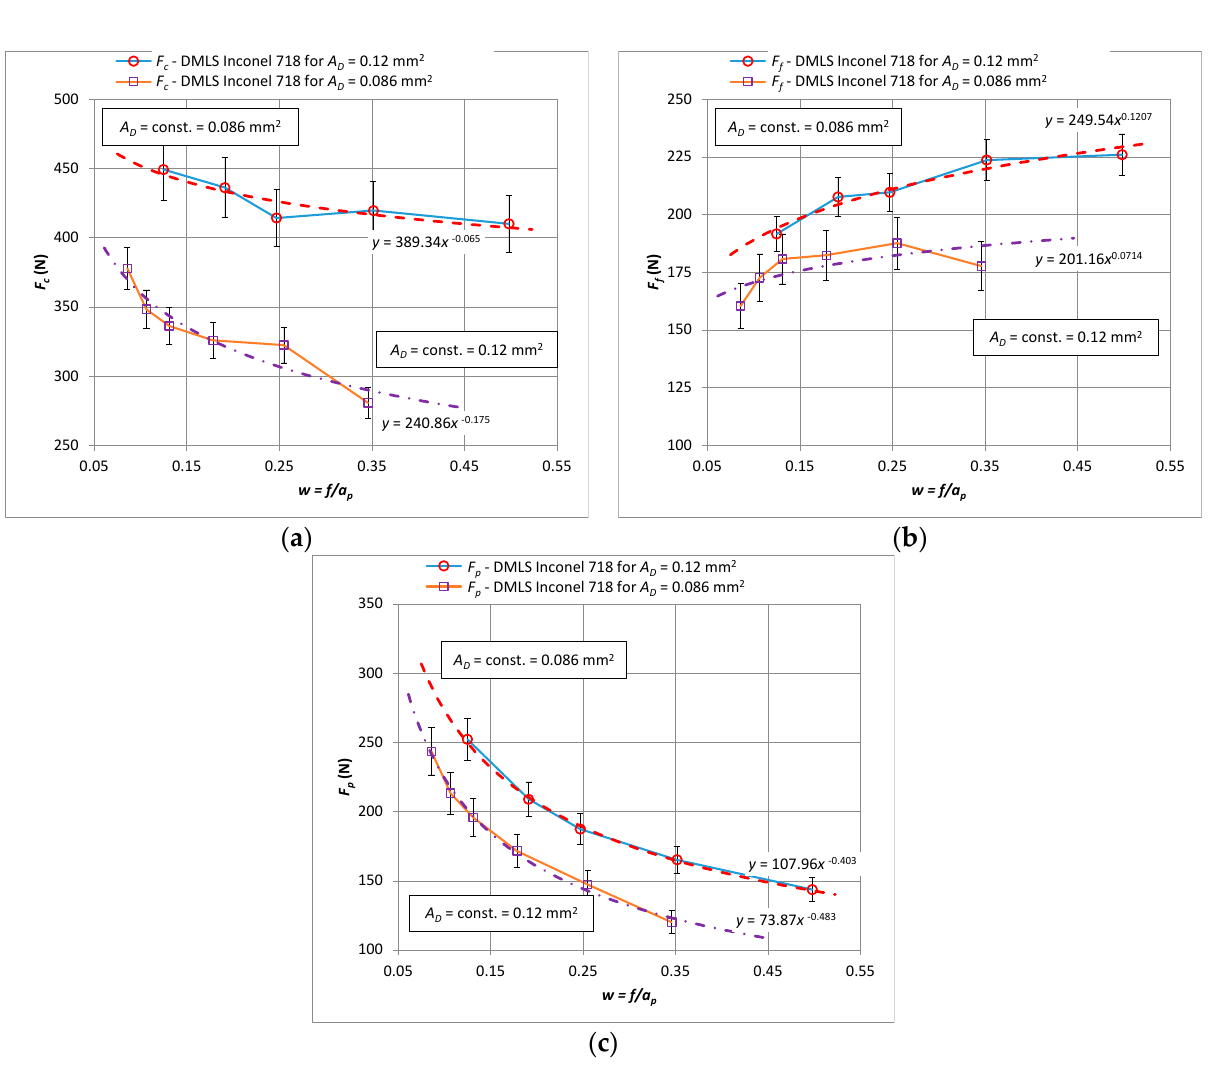
Figure 5. The characteristic of the components for turning with a constant cross-section of the cutting layer A D = 1.2 mm 2 for the printed Inconel 718 alloy, ( a ) F c component, ( b ) F f component, ( c ) F p component.